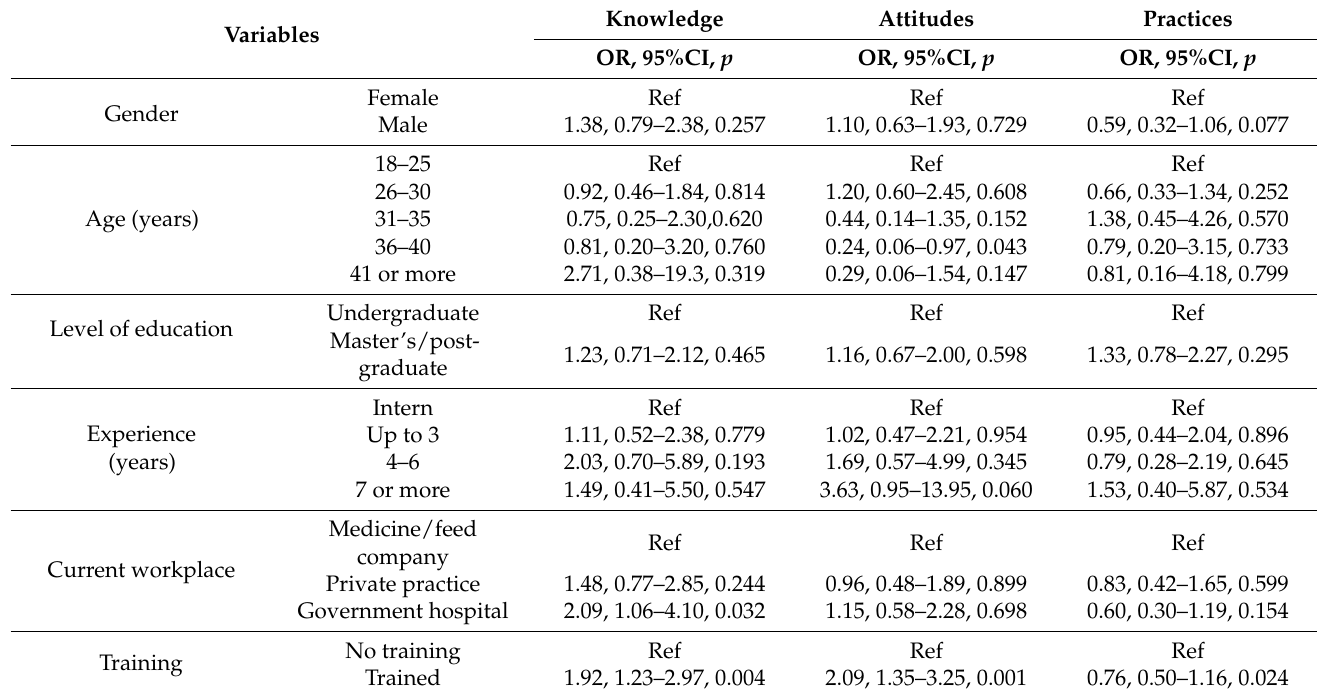
Table 6. Logistic regression analysis of the factors associated with respondents’ knowledge, attitudes, and practices on AMU and